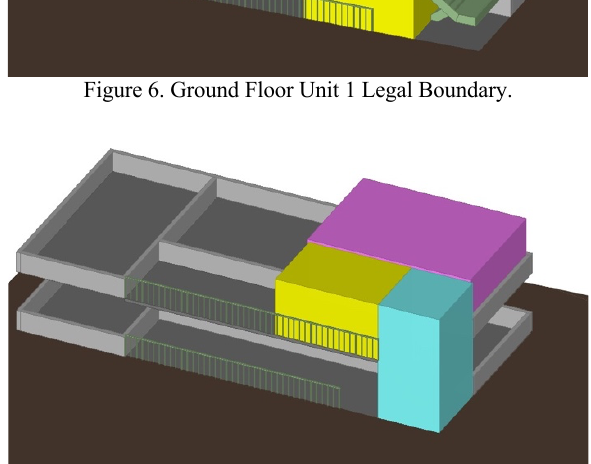
Figure 7. First Floor Unit 1 Legal Boundary.